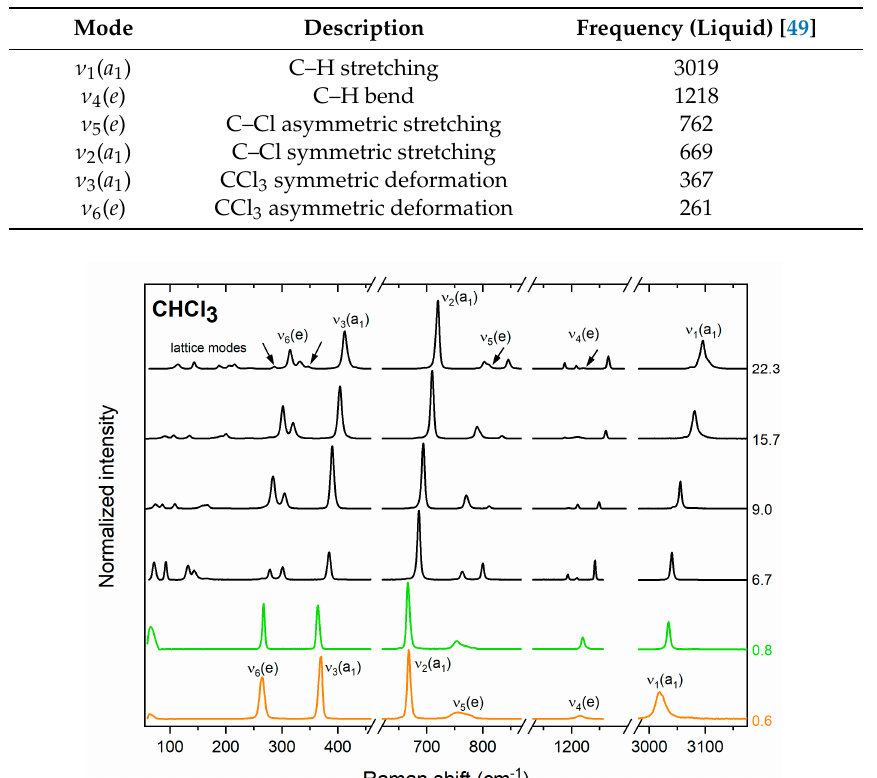
Table 2. Intramolecular vibrations of chloroform (CHCl 3 ). Experimental frequency is given in cm − 1 .